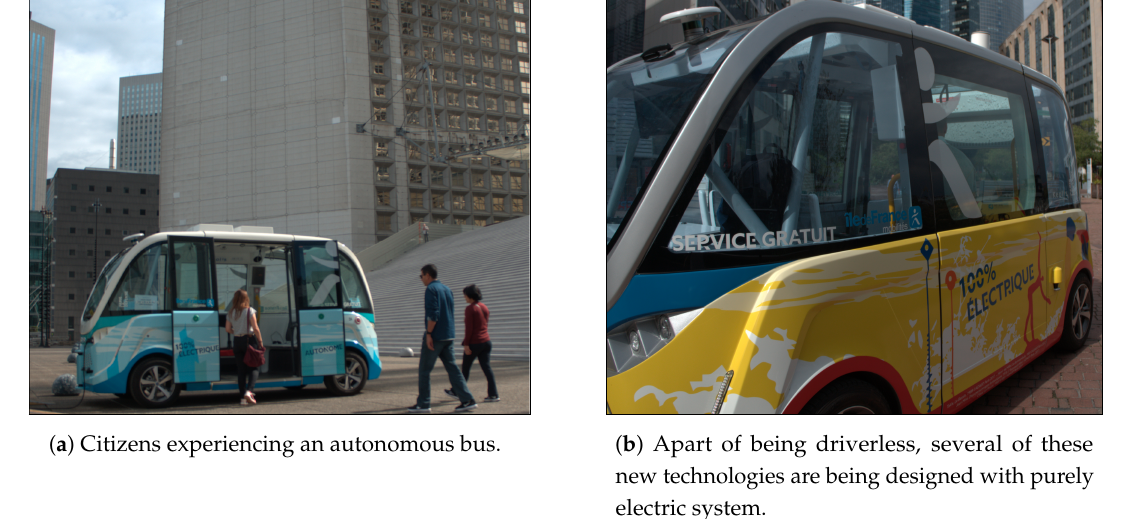
Figure 3. A driverless bus in La Défense , Paris ( c (cid:13) Thays A. Oliveira, CC BY-SA